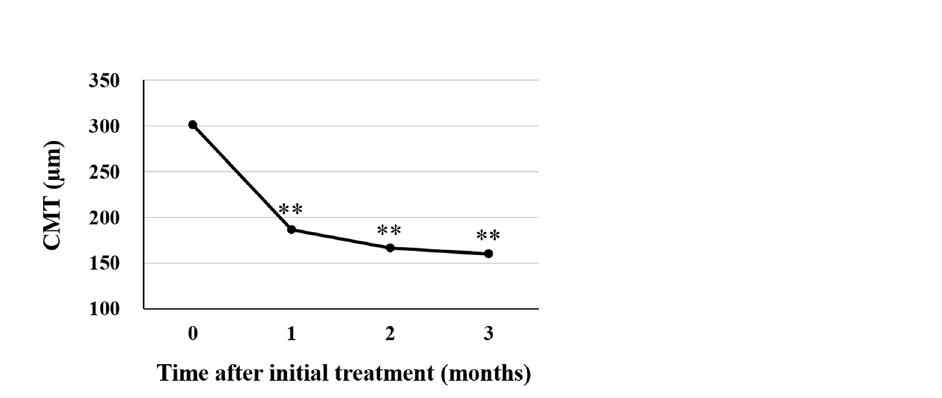
Figure 2. Change of average central macular thickness (CMT) in 36 eyes with neovascular age-related macular degeneration associated with type 1 choroidal neovascularization treated with 3 monthly intravitreal injections of brolucizumab. CMT showed significant improvement after the first injection of brolucizumab (** P < 0.001). Data are expressed as means.